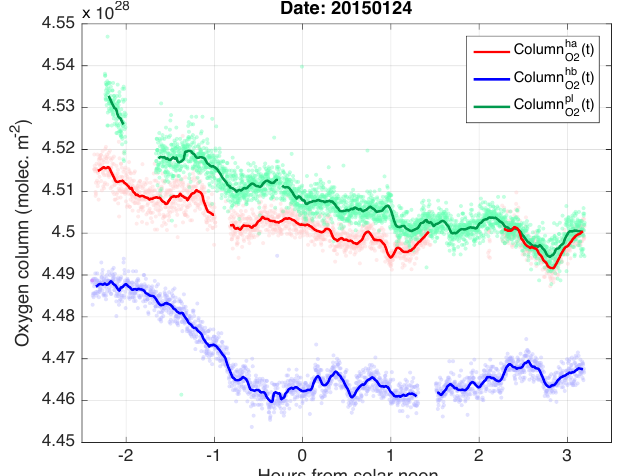
Figure D1. Oxygen column number densities measured by ha, hb, and pl on 24 January